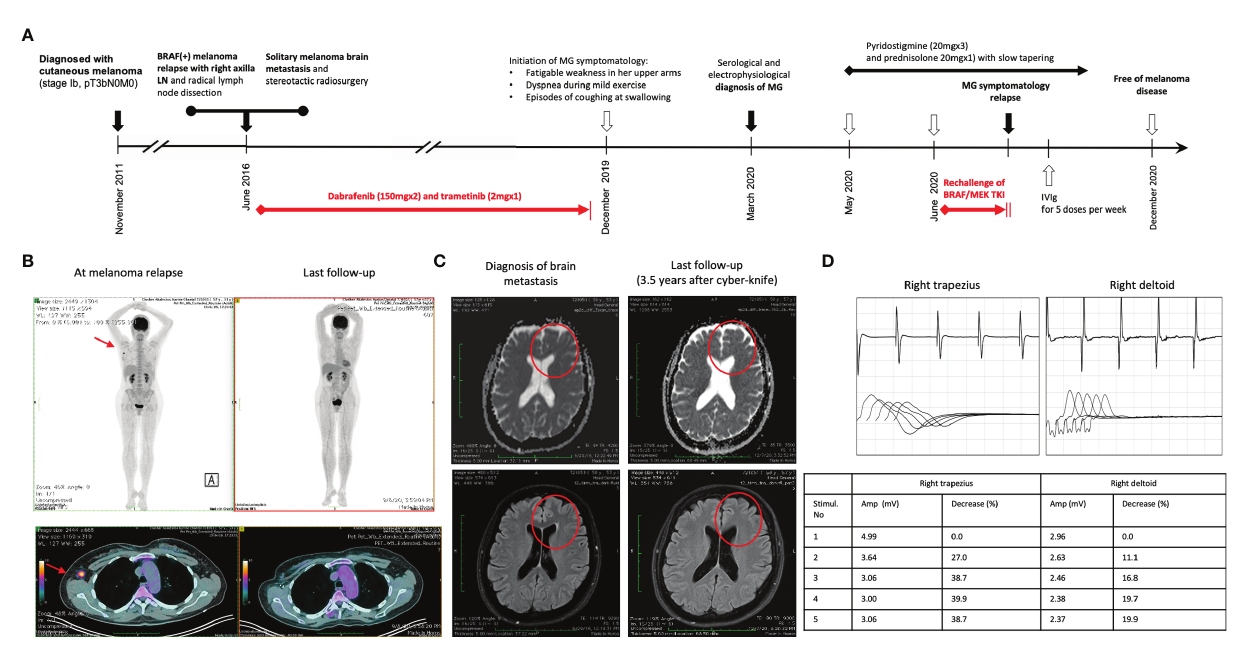
FIGURE 1 | (A) Timeline of therapy and disease status for both melanoma and MG. (B) PET/CT fi ndings at melanoma relapse and at the last follow-up. (C) MRI fi ndings at melanoma brain metastasis diagnosis and at 3.5 years after stereotactic radiosurgery. (D) The results of RNS test in the right deltoid muscle and the right trapezoid muscle at the time of clinical presentation of myasthenia